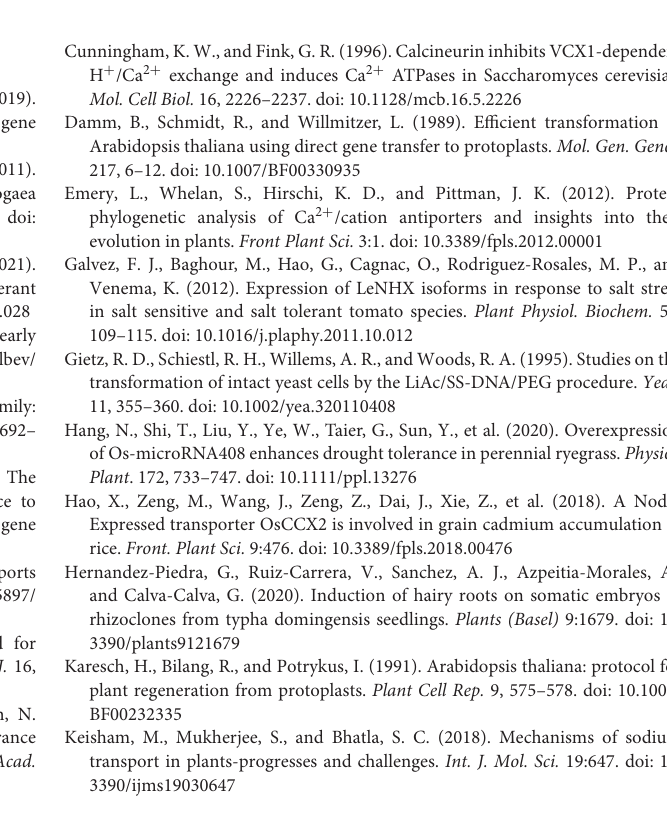
Supplementary Figure 1 | Tolerance of yeast transformants expressing MdCCX1 or the pDR196 to different metal ions. (A) Comparison of tolerance of K667 yeast strains expressing MdCCX1 or the pDR196 to Li + , Mn 2 + , Cd 2 + , Ba 2 + , Cu 2 + , or Mg 2 + . (B) Phenotypes of R5421 yeast strains expressing MdCCX1 or the pDR196 grown in AP medium supplemented with different concentrations of K + . Pictures were captured after 3 days of growth at 28 ◦ C. Two positive transformets of each type were used in the experiment. Supplementary Figure 2 | Identification of transgenic Arabidopsis and calli. (A) PCR identification of the MdCCX1 transgene based on genomic DNA extracted from Arabidopsis plants. Genomic DNA extracted from “Col” plants and H 2 O were used as negative controls, and the MdCCX1 -pBI121 vector plasmid was used as a positive control. (B) Expression level of MdCCX1 in transgenic Arabidopsis plants. AtActin served as an internal reference gene. (C) PCR identification of the MdCCX1 transgene based on genomic DNA extracted from apple calli. Genomic DNA extracted from WT calli and H 2 O were used as negative controls, and the MdCCX1 -pBI121 vector plasmid was used as a positive control. (D) Expression level of MdCCX1 in transgenic apple calli. MdMDH served as an internal reference gene. Bars labeled with different letters in each panel are significantly different ( p < 0.05, one-way ANOVA analysis and Duncan’s test). Supplementary Figure 3 | Histochemical staining of apple leaves. (A) Histochemical staining of hydrogen peroxide (H 2 O 2 ) in apple leaves using NBT (nitro blue tetrazolium). (B) Histochemical staining of superoxide anion (O 2 − ) in apple leaves using DAB (3,3 (cid:48) -diaminobenzidine). Scale bars, 3